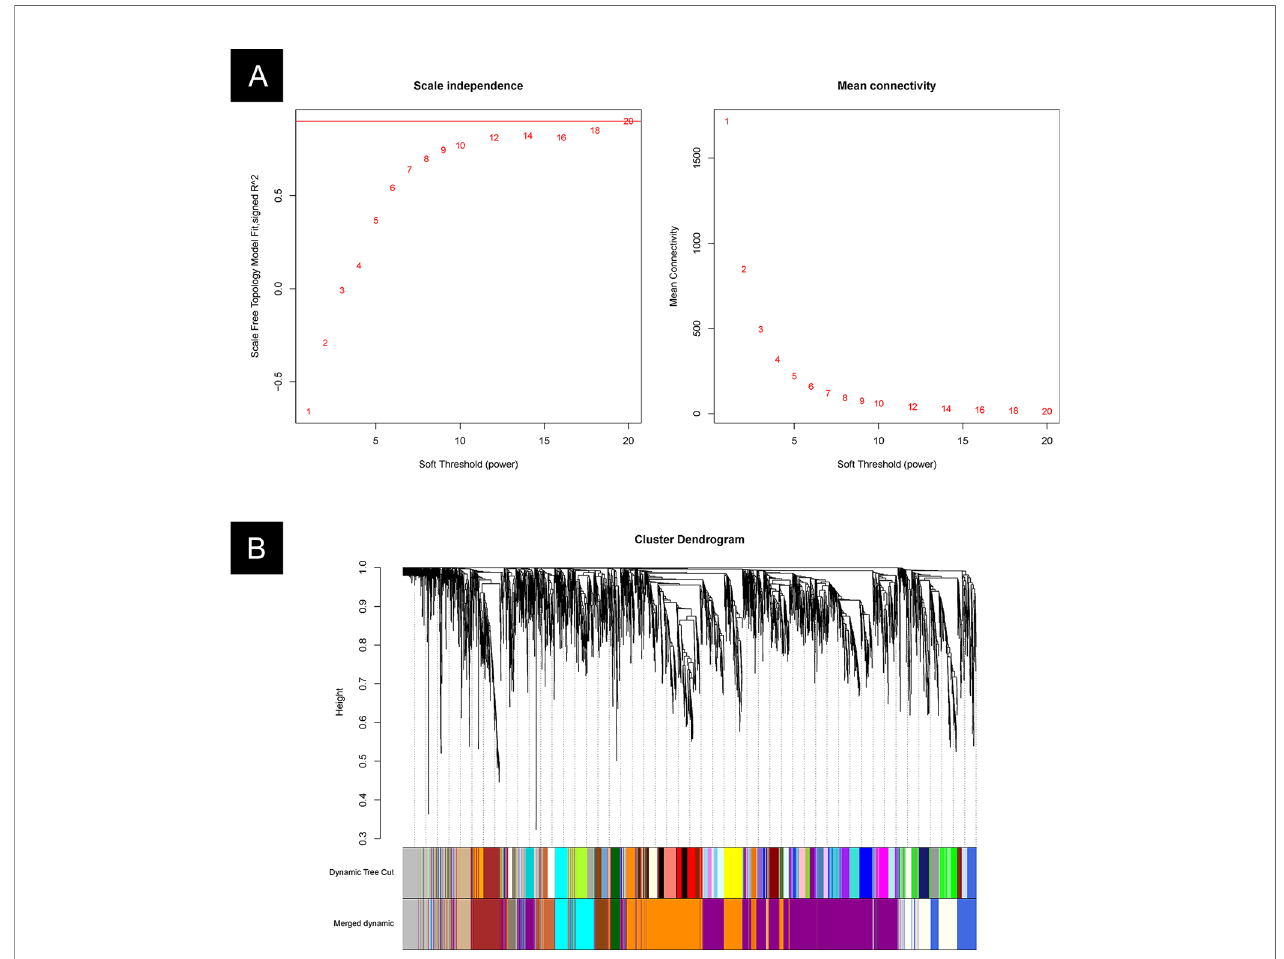
FIGURE 7 | WGCNA cluster analysis. (A) Plot of the strength of correlation against a series (range 2 to 20) of soft threshold powers. (B) Gene clusters and gene module